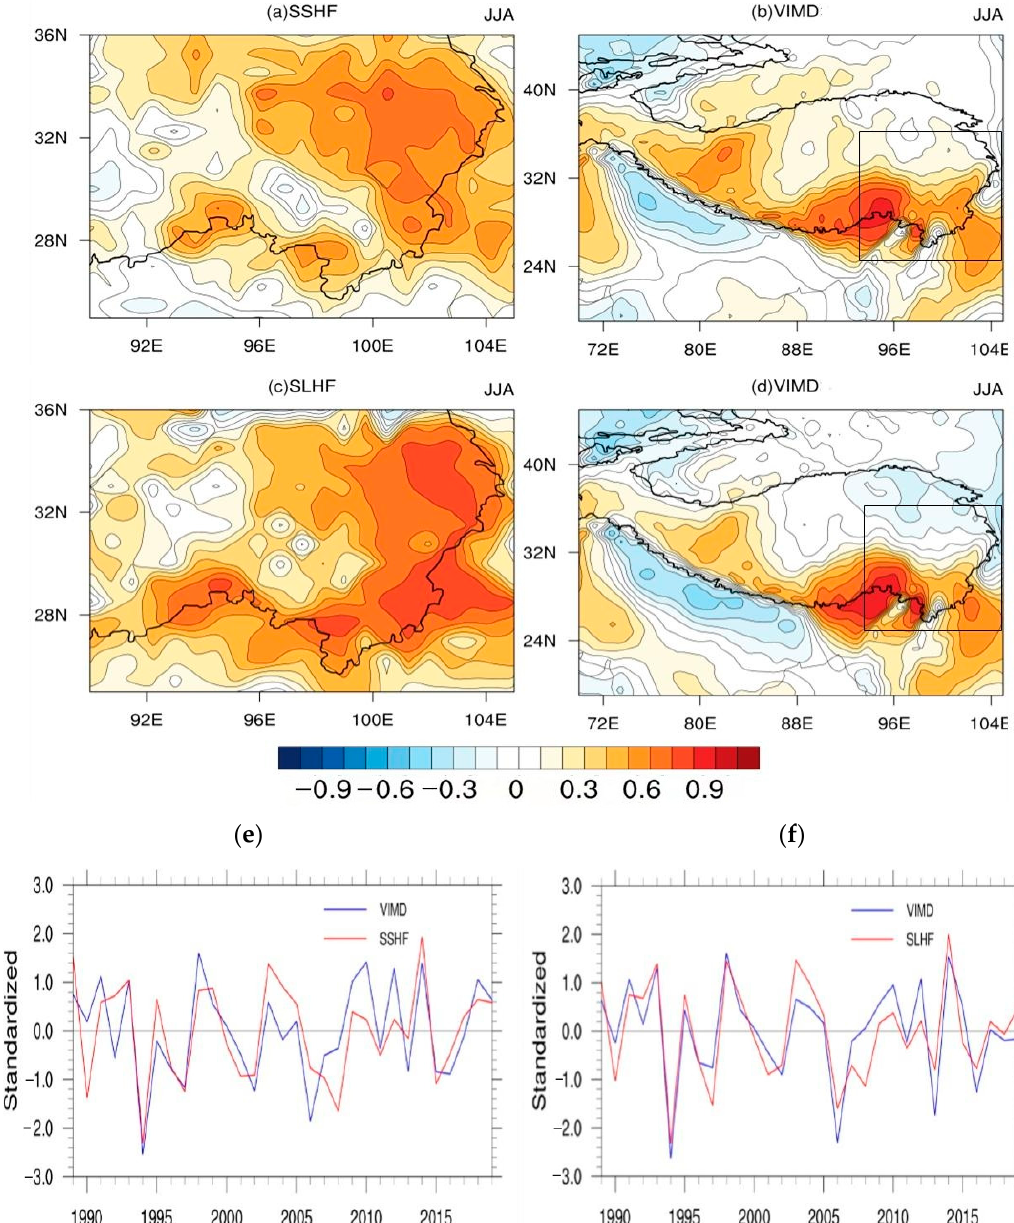
Figure 9. ( a – d ) SVD analysis and ( e , f ) corresponding time series of the surface flux field and northward water vapor flux field in southeastern Tibet during the AMS. ( a ) the first mode of the thermal field; ( b ) the first mode of the northward water vapor flux field; ( c ) the first mode of the latent heat field; ( d ) the first mode of the northward water vapor flux field; ( e ) the sensible heat flux and northward water vapor flux field; and ( f ) the latent heat flux and northward water vapor flux field. The solid black line is the boundary of the Tibetan Plateau in ( a – d ). The solid red line is SSHF time series and the solid blue line is VIMDF time series in ( e , f